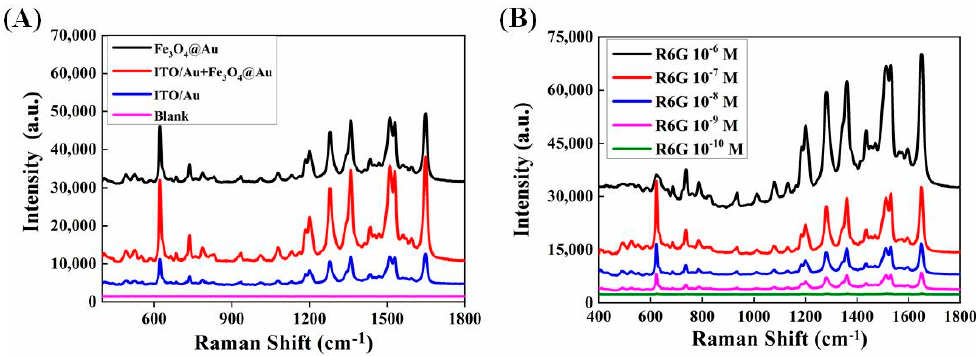
Figure 5. ( A ) Raman spectra of 10 − 6 mol/L R6G on optimal ITO/Au, Fe 3 O 4 @Au, and sandwich structure of ITO/Au and Fe 3 O 4 @Au. ( B ) Raman spectra of different concentrations of R6G on ITO/Au by using magnetically inducing strategy.